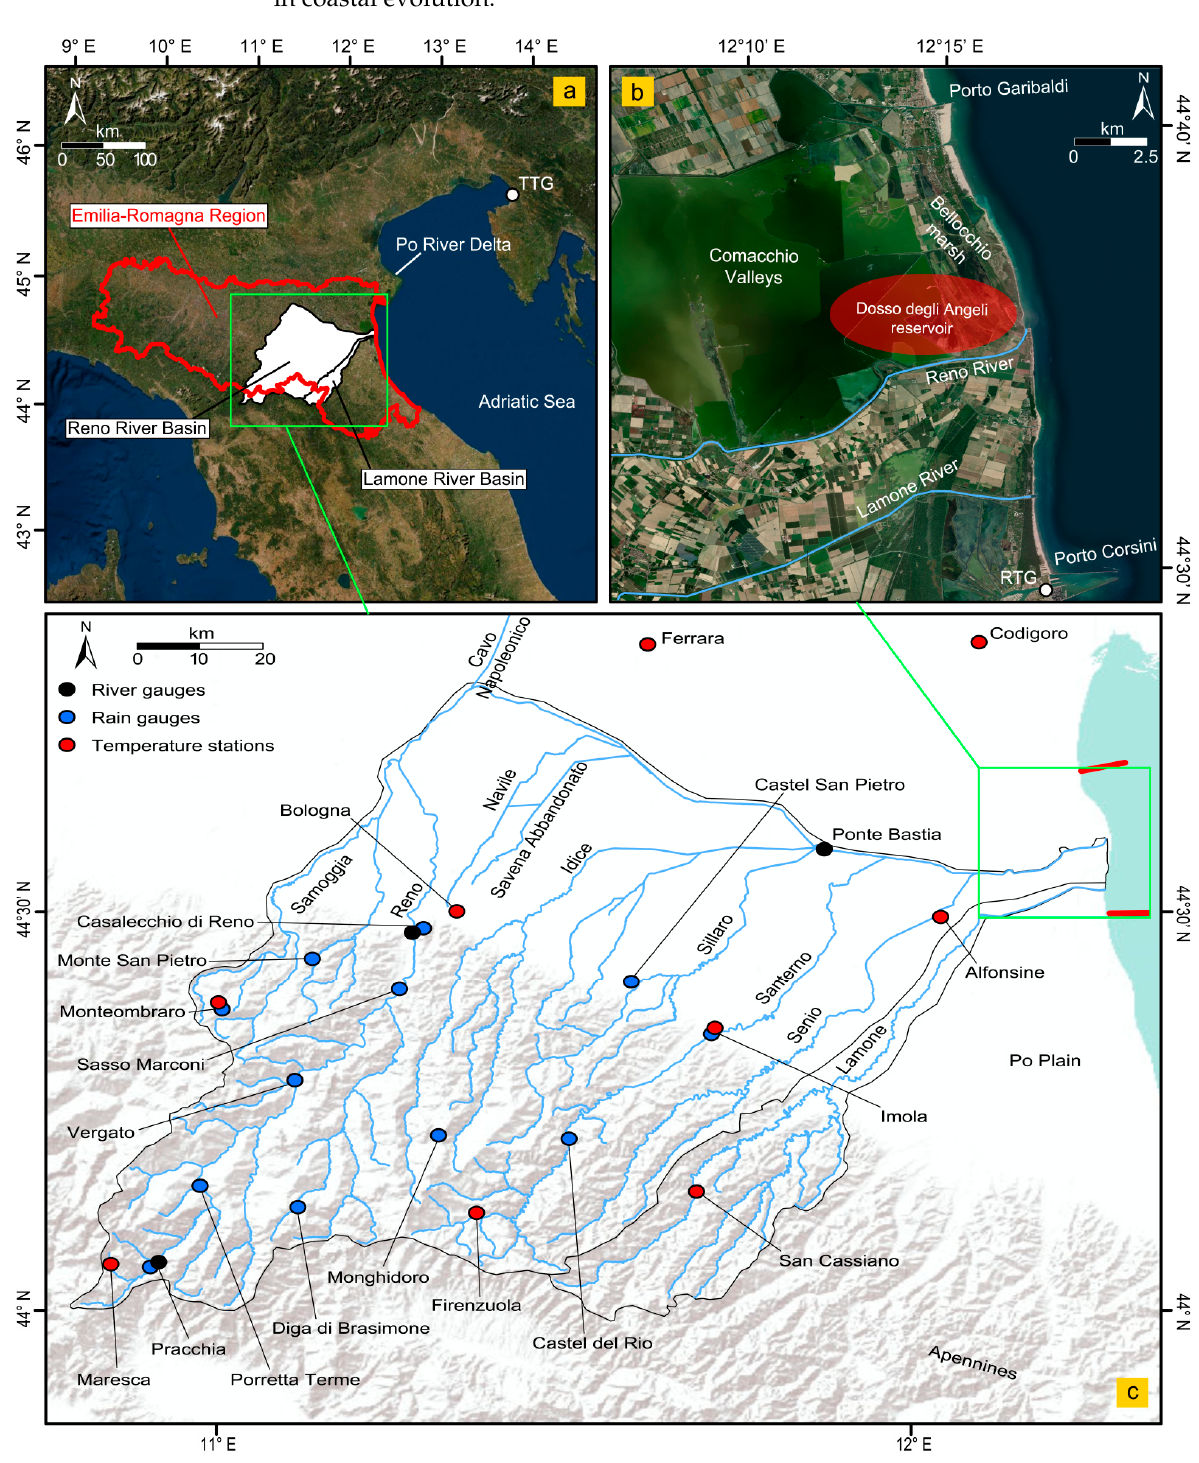
Figure 1. ( a ) Location of the Reno and Lamone river basins in the Emilia-Romagna region, Northern Italy. TTG: Trieste tide gauge; ( b ) the coastal portion of the river basins. RTG: Marina di Ravenna tide gauge; ( c ) detailed map of the Reno and Lamone river basins and tributaries, with position of gauges and stations used in this study.